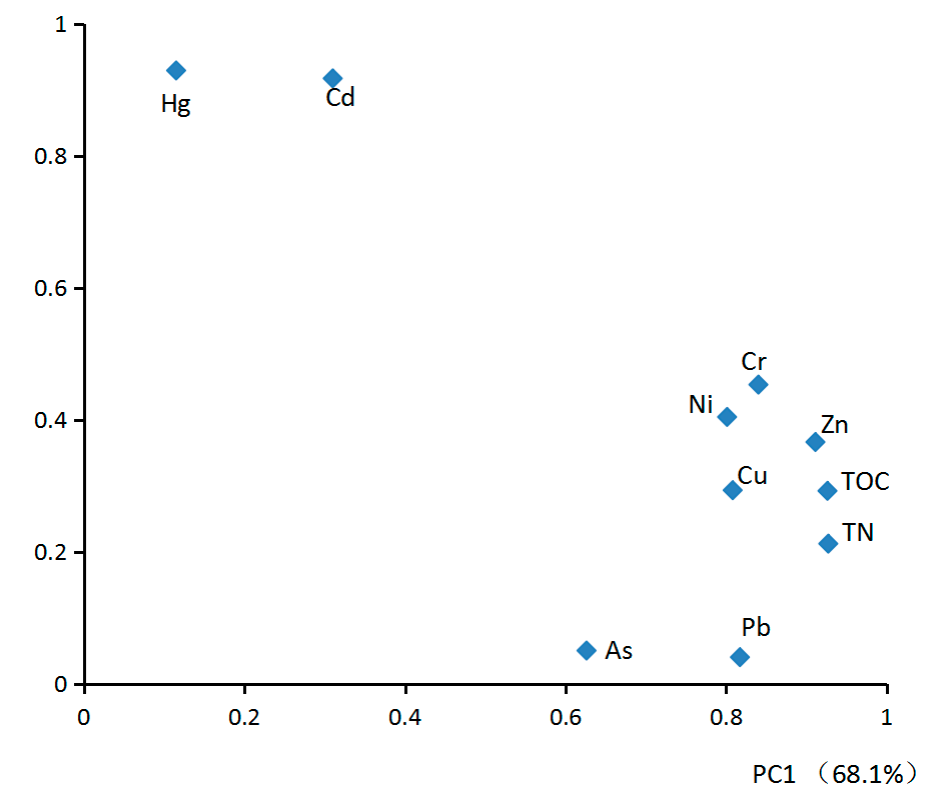
Figure 6. Principal component loading of heavy metals, TOC, and TN.